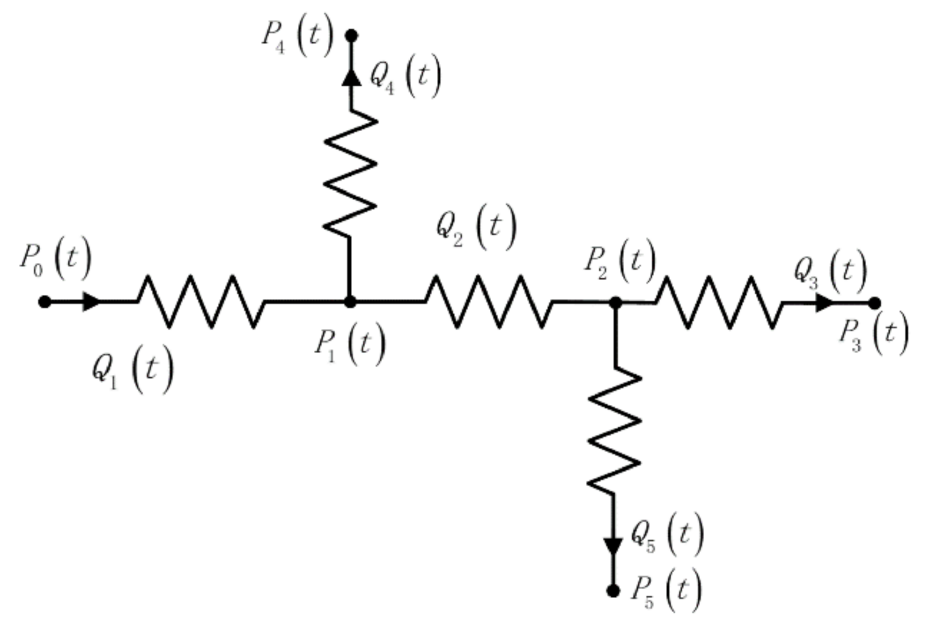
Figure 5. Fluidic resistors of the microfluidic circuit.